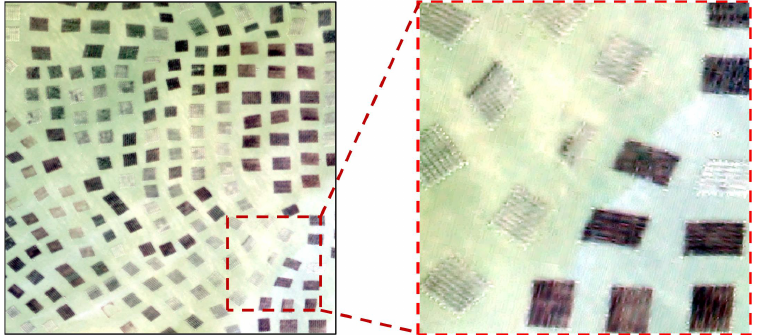
Figure 2. Raft aquaculture areas images: Remote sensing images of laver raft aquaculture areas with 1.8-m spatial resolution. The right image shows the close-up view of the raft aquaculture areas image denoted by red dashed boxes in the left